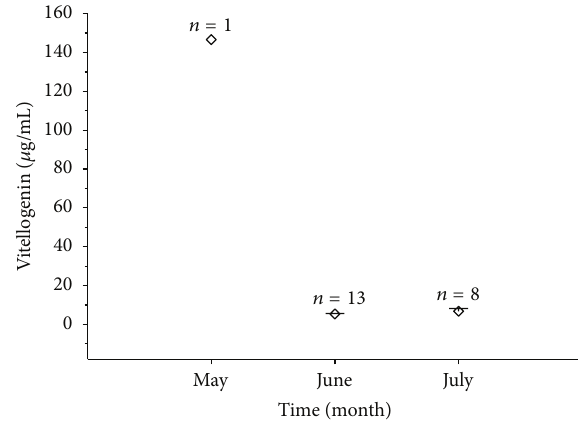
Figure 2: Mean detectable vitellogenin concentration in turtles captured in water in 2008 and 2009. There was no significant difference in mean detectable vitellogenin in samples from in-water captures in June and July ( 𝑃 > 0.05 ). One individual sampled in May 2009 (female, SCL = 93 cm) had a substantially higher concentration of vitellogenin in comparison to turtles sampled in June and July. Error bars represent the standard error of the mean.